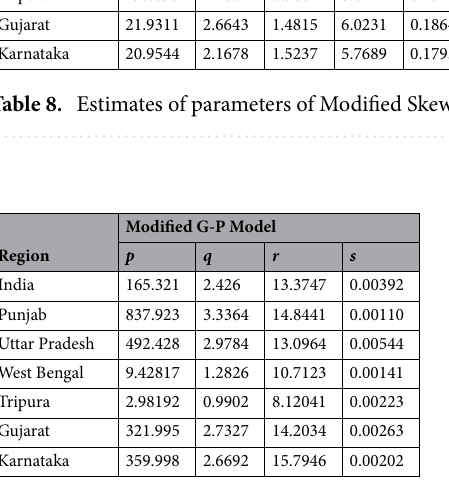
Table 9. Estimates of parameters of Modified G-P Model for India and 6 selected states.